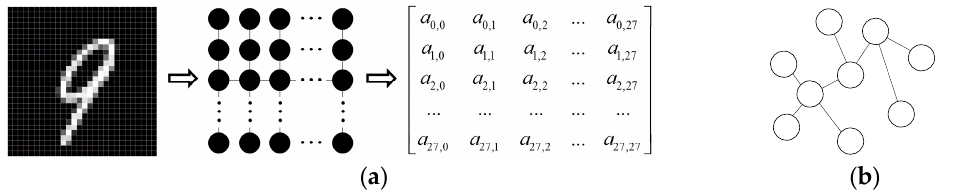
Figure 1. ( a ) An image of the number “9” in the MNIST handwritten digit database and ( b ) a graph composed of nodes and edges.